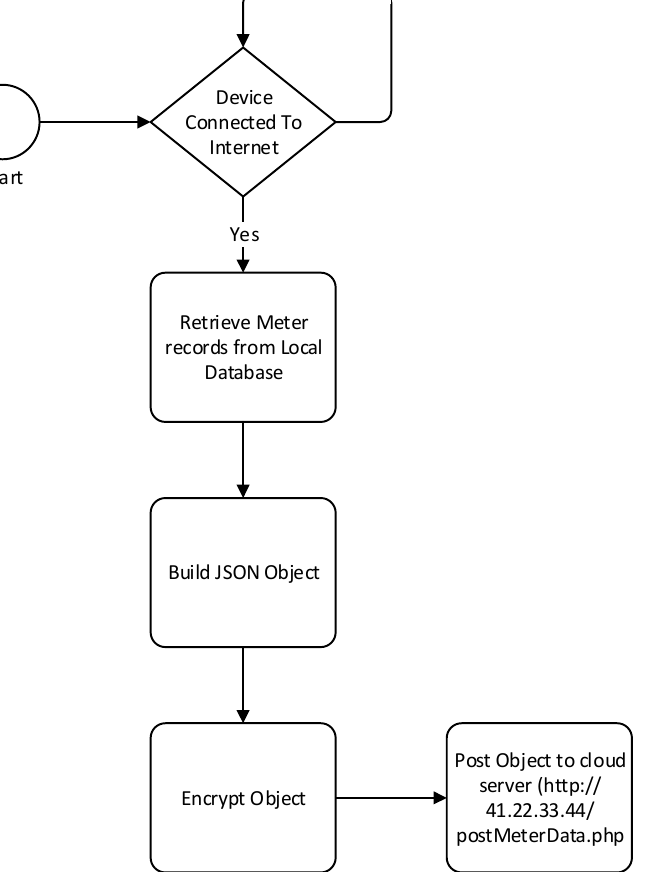
Figure 12. Data mule to Billing Server Upload.